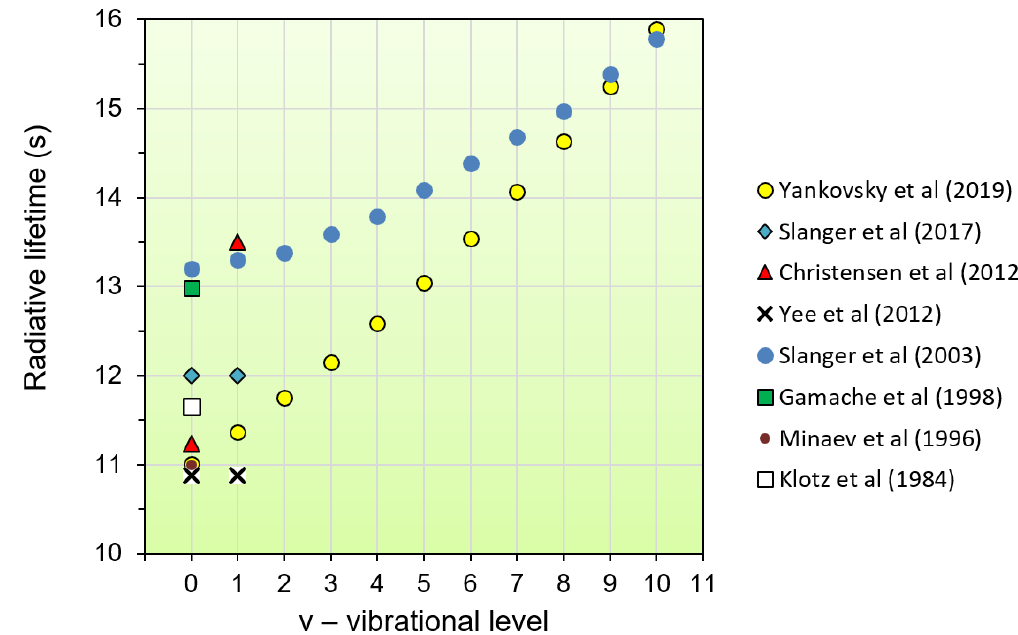
Figure 7. Currently known estimations of O 2 (b 1 Σ g + , v = 0–10) radiative lifetimes [2,24,25,74,84–87].